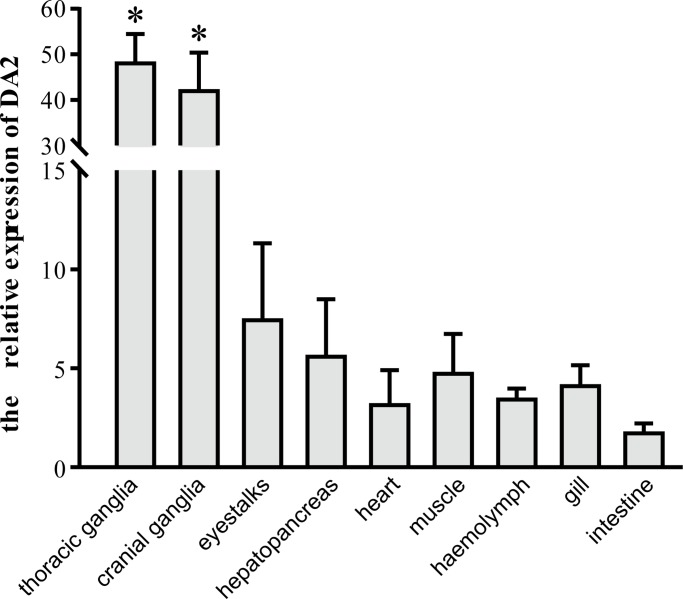
Expression level of the DA2 gene normalized to 18S expression in the thoracic ganglia, cranial ganglia, eyestalks, gill, heart, muscle, hepatopancreas, intestine, and haemolymph of the crab.Values are the mean ± SE (n = 4–6). *indicates that expression in the corresponding tissues is significantly different from expression in the control organ (intestine) at P<0.05.